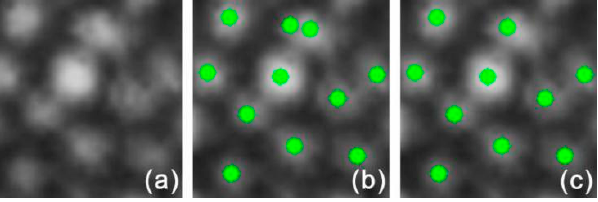
Figure 8. Merging of closed identified cone cells. ( a ) Denoised AO-SLO image patch. Identification results ( b ) before and ( c ) after merging (green dots) on the denoised AO-SLO image patch.